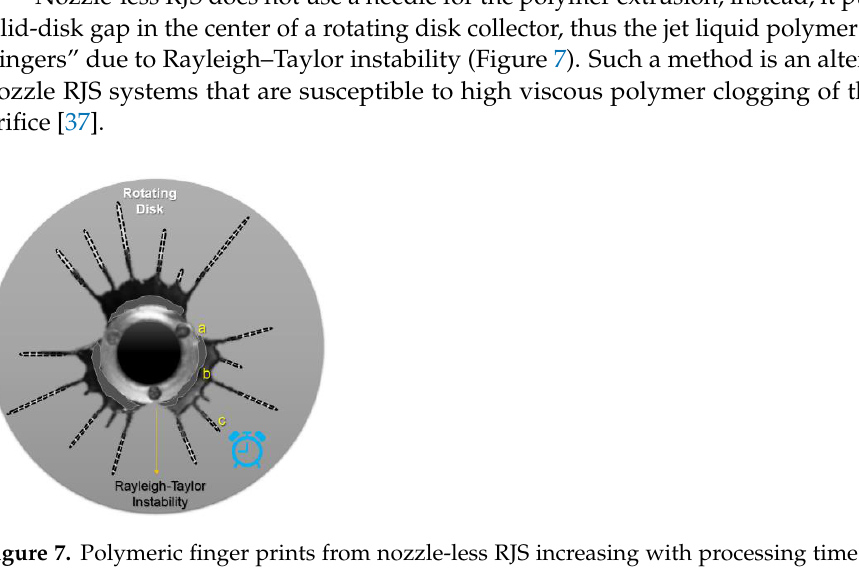
Figure 6. Immersion RJS scheme (modified with permission from [78], Copyright 2017 John Wiley & Sons).